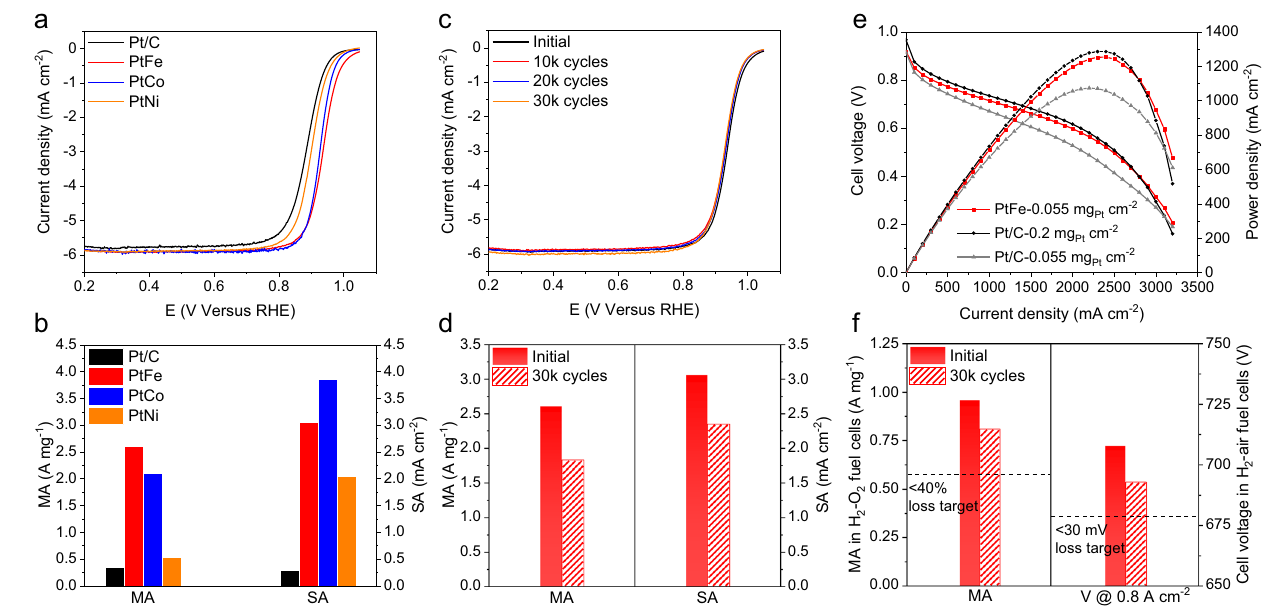
Fig. 5 | Electrocatalytic performance. a Oxygen reduction reaction (ORR) polar- ization curves of the Pt/C, PtFe, PtCo, and PtNi catalysts (with internal resistance corrected). b Comparison of mass activities (MAs) and speci fi c activities (SAs) of the catalysts at 0.9V (versus reversible hydrogen electrode (RHE)). The SAs were normalized by the electrochemical surface areas (ECSAs) estimated from CO